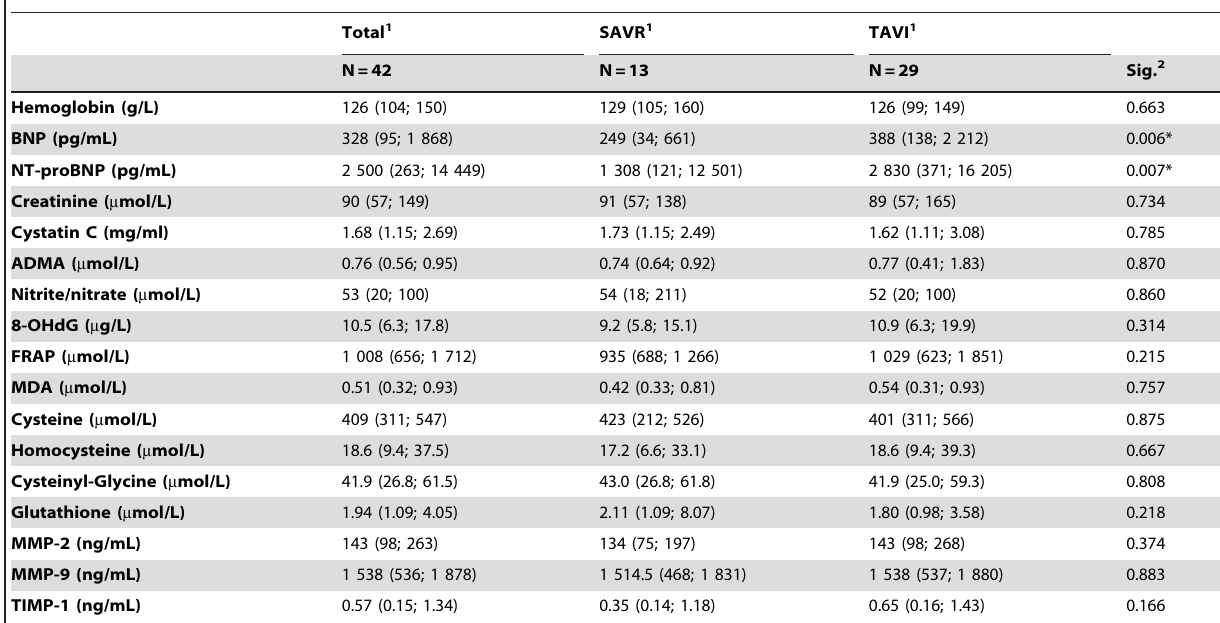
Table 2. Laboratory characteristics of SAVR and TAVI groups.